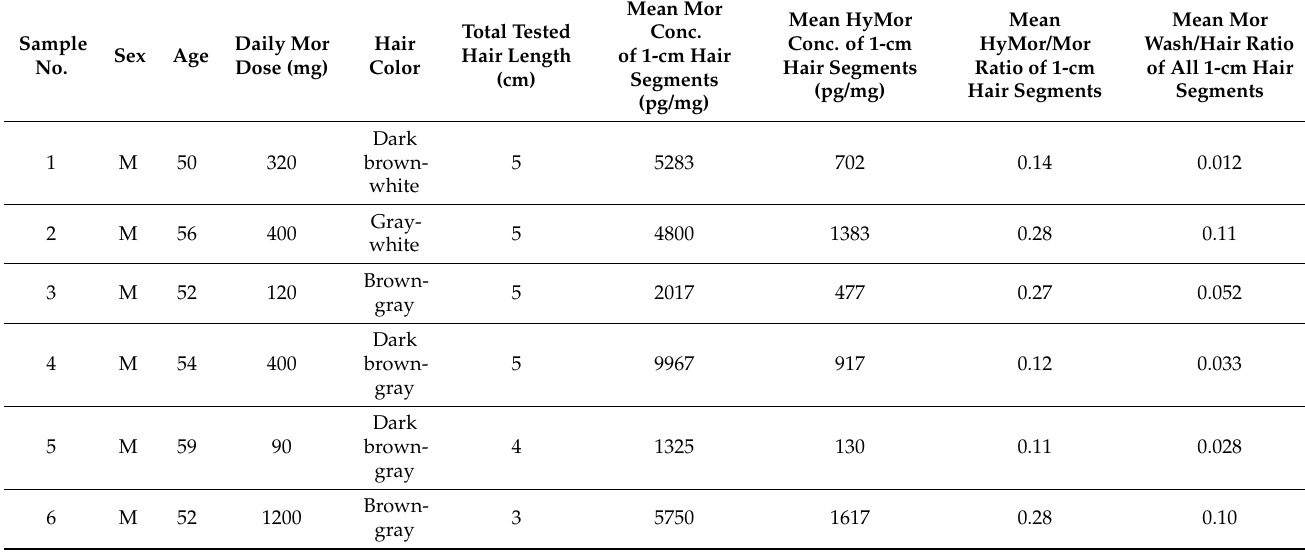
Table 4. Details on chronic morphine users.